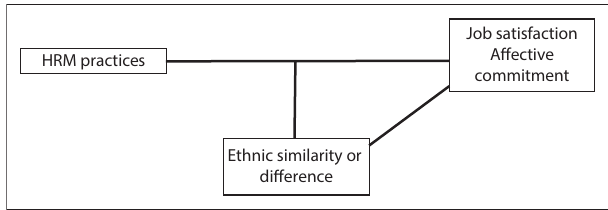
FIG URE 1: Hypothesised